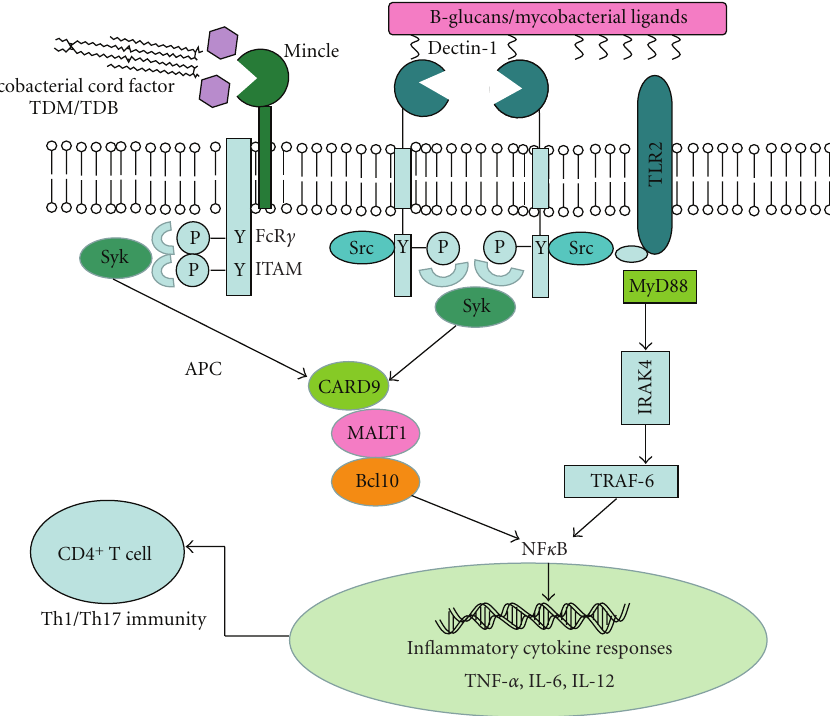
Figure 1: Mincle- and Dectin-1-mediated signalling in response to mycobacteria. Upon recognition of their mycobacterial ligands, Dectin-1 and Mincle signal via the Syk/CARD9 pathway for the production of inflammatory cytokines and the induction of Th1 and Th17 responses. There is also evidence that Dectin-1 signalling can cooperate with TLR2 to induce protective